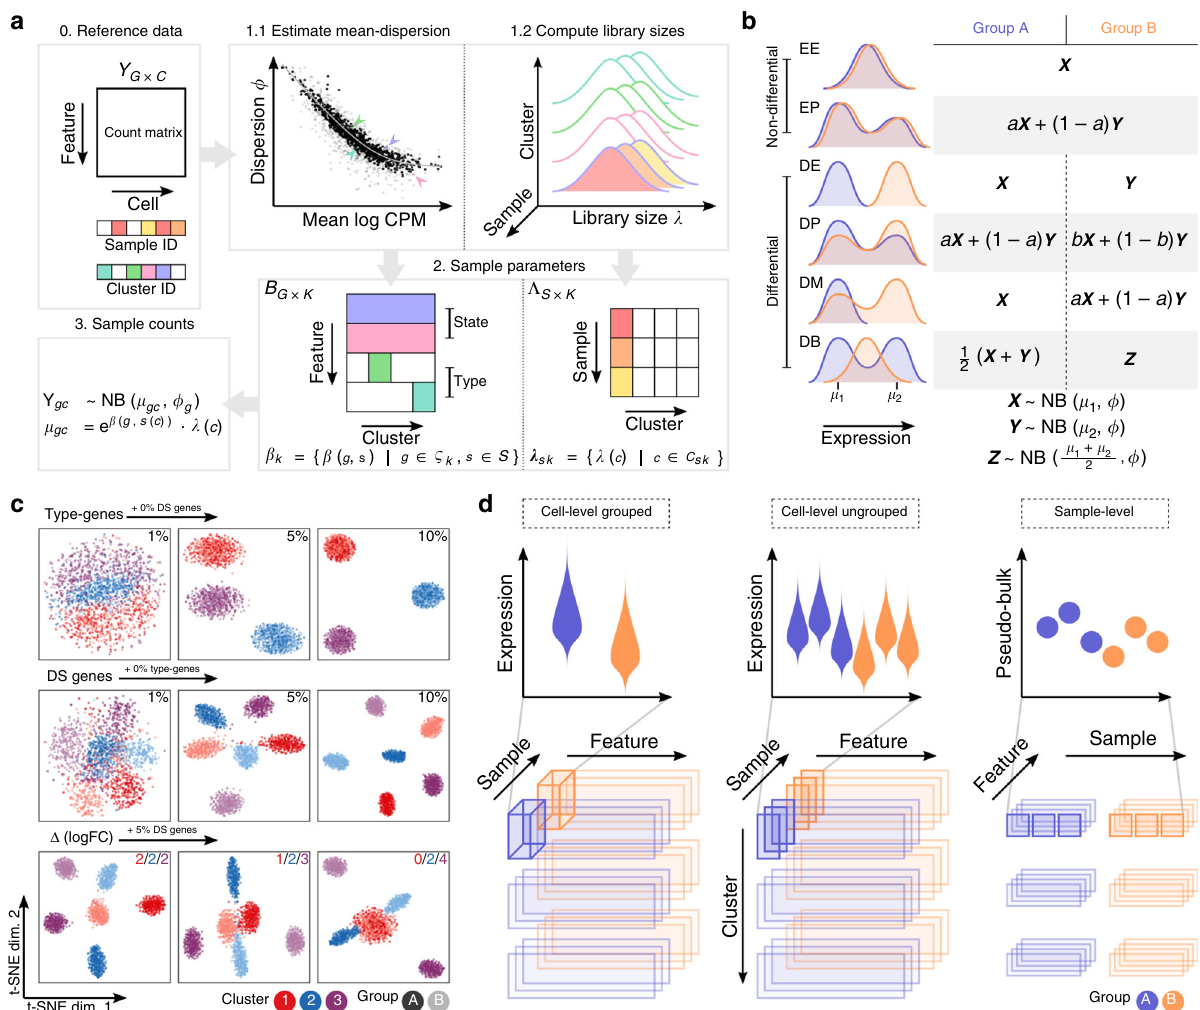
Fig. 1 Schematic overview of muscat ’ s simulation framework. a Given a count matrix of features by cells and, for each cell, predetermined cluster (subpopulation) identi fi ers as well as sample labels (0), dispersion and sample-wise means are estimated from a negative binomial distribution for each gene (for each subpopulation) (1.1); and library sizes are recorded (1.2). From this set of parameters (dispersions, means, and library sizes), gene expression is sampled from a negative binomial distribution. Here, genes are selected to be “ type ” (subpopulation-speci fi cally expressed; e.g., via marker genes), “ state ” (change in expression in a condition-speci fi c manner), or equally expressed (relatively) across all samples (2). The result is a matrix of synthetic gene expression data (3); b Differential distributions are simulated from an NB distribution or mixtures thereof, according to the de fi nitions of random variables X , Y , and Z . c t-SNE plots for a set of simulation scenarios with varying percentage of “ type ” genes (top), DS genes (middle), and the difference in the magnitude (logFC) of DS between subpopulations (bottom). d Schematic overview of cell- and sample-level approaches for DS analysis. Top panels show a schematic of the data distributions or aggregates across samples (each violin is a group or sample; each dot is a sample) and conditions (blue or orange). The bottom panels highlight the data organization into sub-matrix slices of the original count